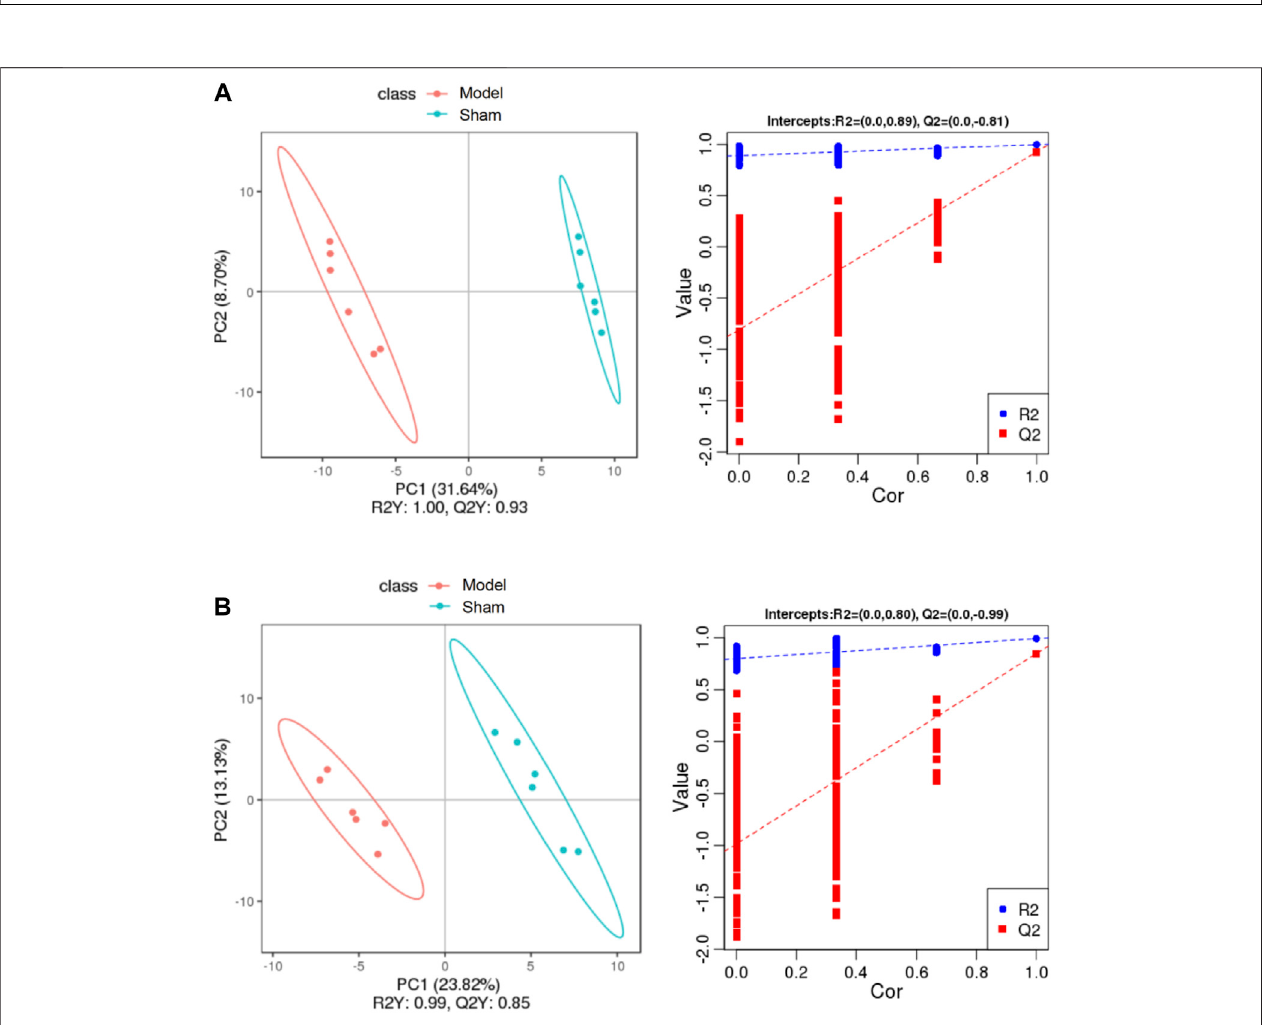
Frontiers in Pharmacology |